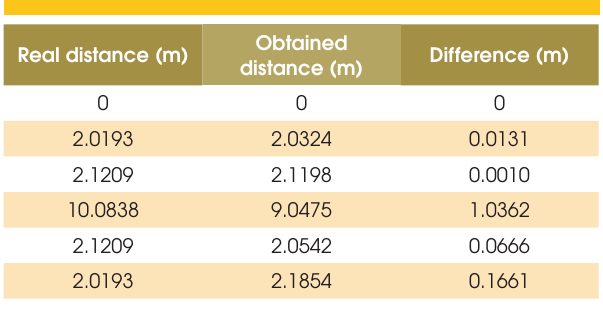
Figure 14 – Speed per axle obtained from a deformation time-series due the passage of a DASH-9 locomotive at midspan